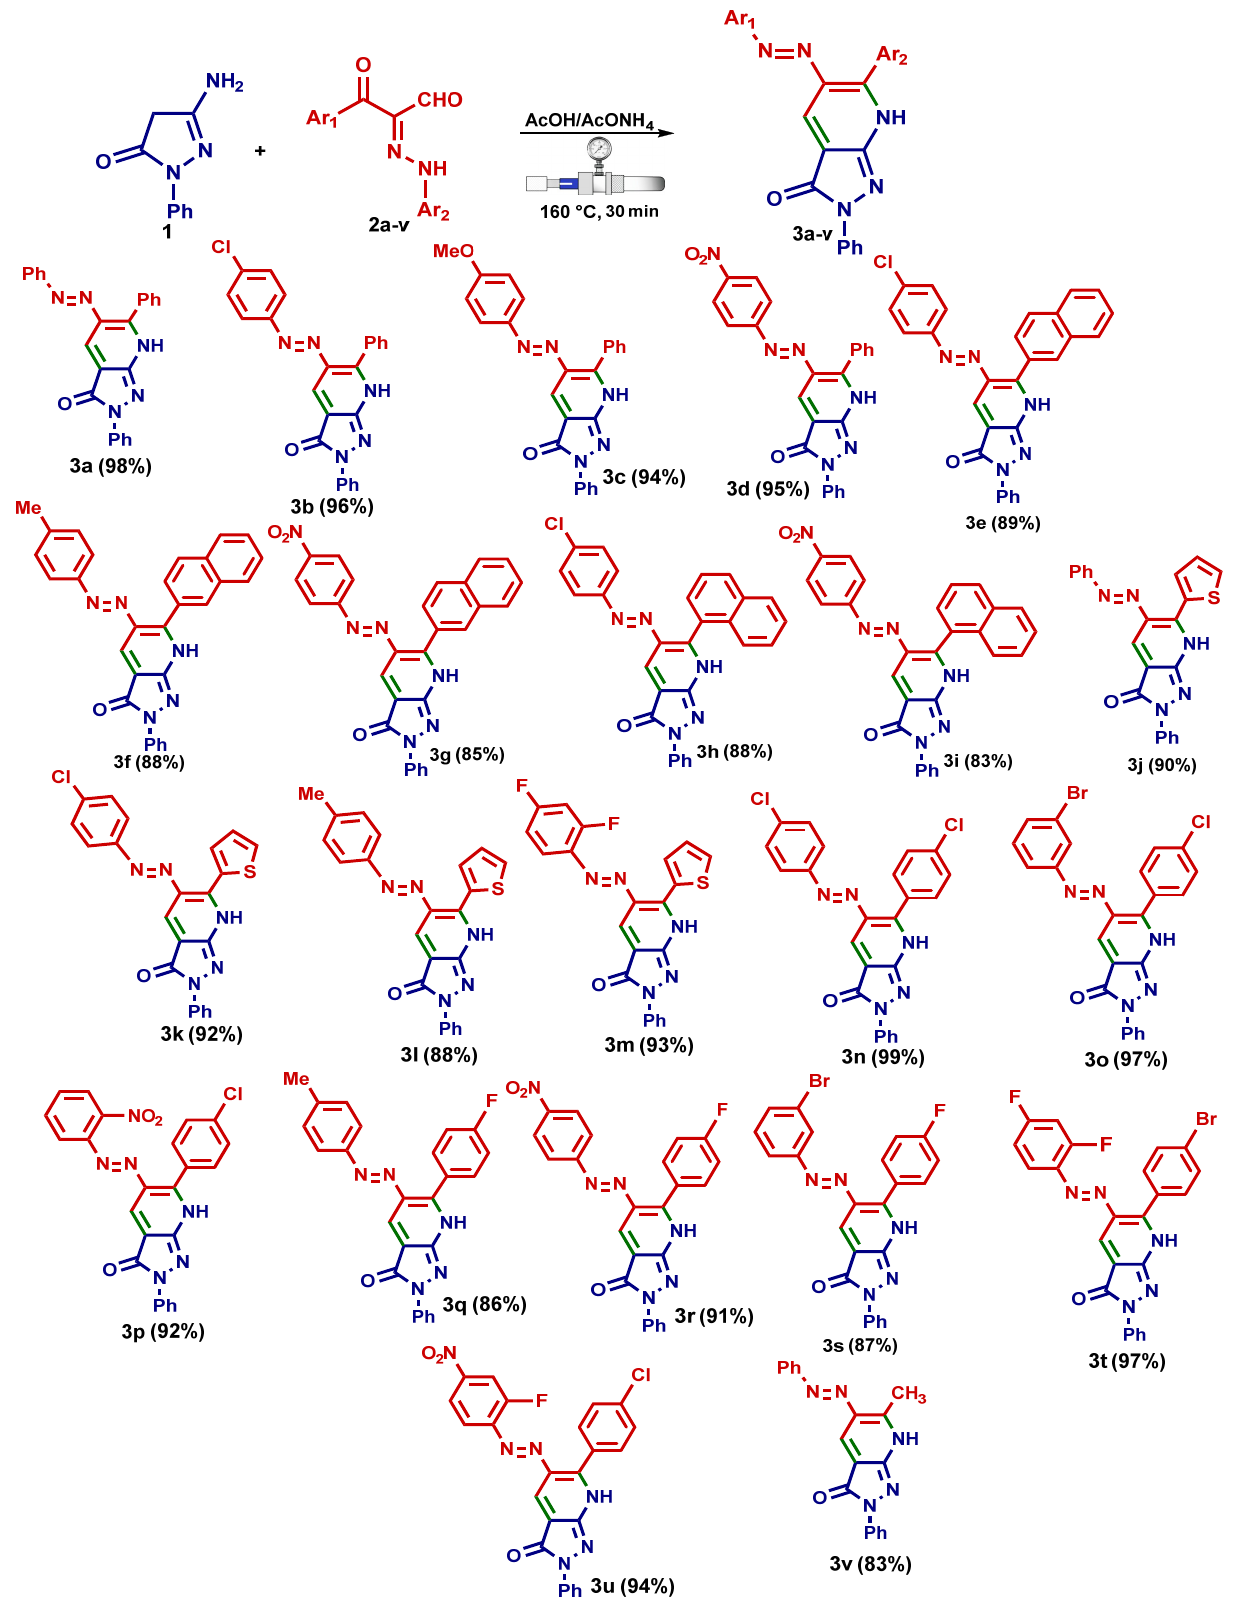
Figure 2. Cyclocondensation reactions between pyrazol-3-one 1 and arylhydrazonals 2 using Q-tube.